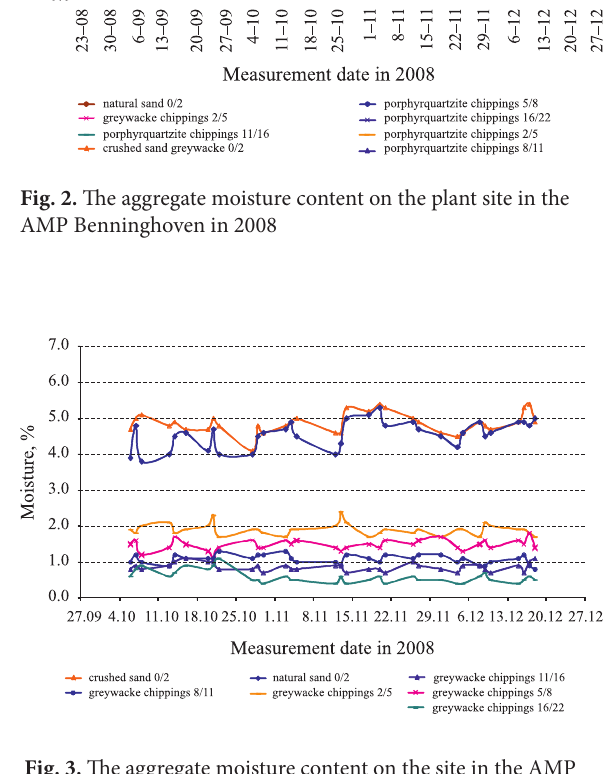
Fig. 3. The aggregate moisture content on the site in the AMP Ermont – Magnum 260 in